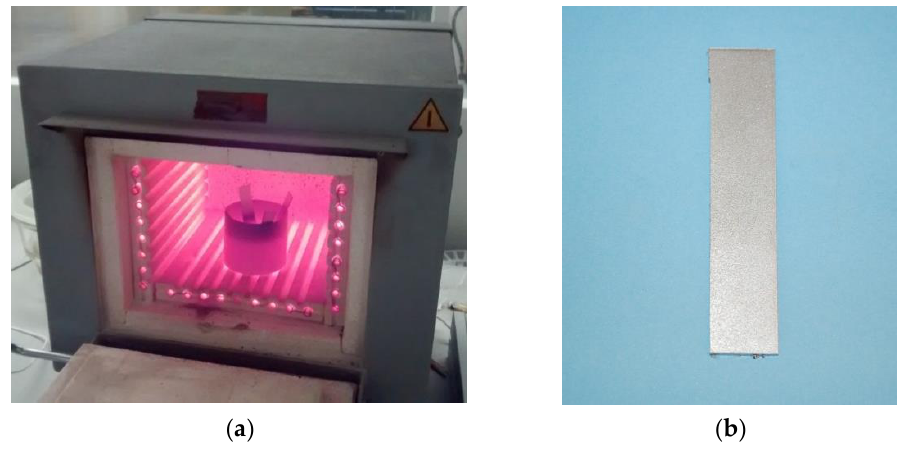
Figure 12. ( a ) Samples immersed in Li 2 CO 3 at 800 °C in oven; ( b ) sample before testing. The thickness, continuity and homogeneity of the oxide layer were the parameters evaluated in each sample.